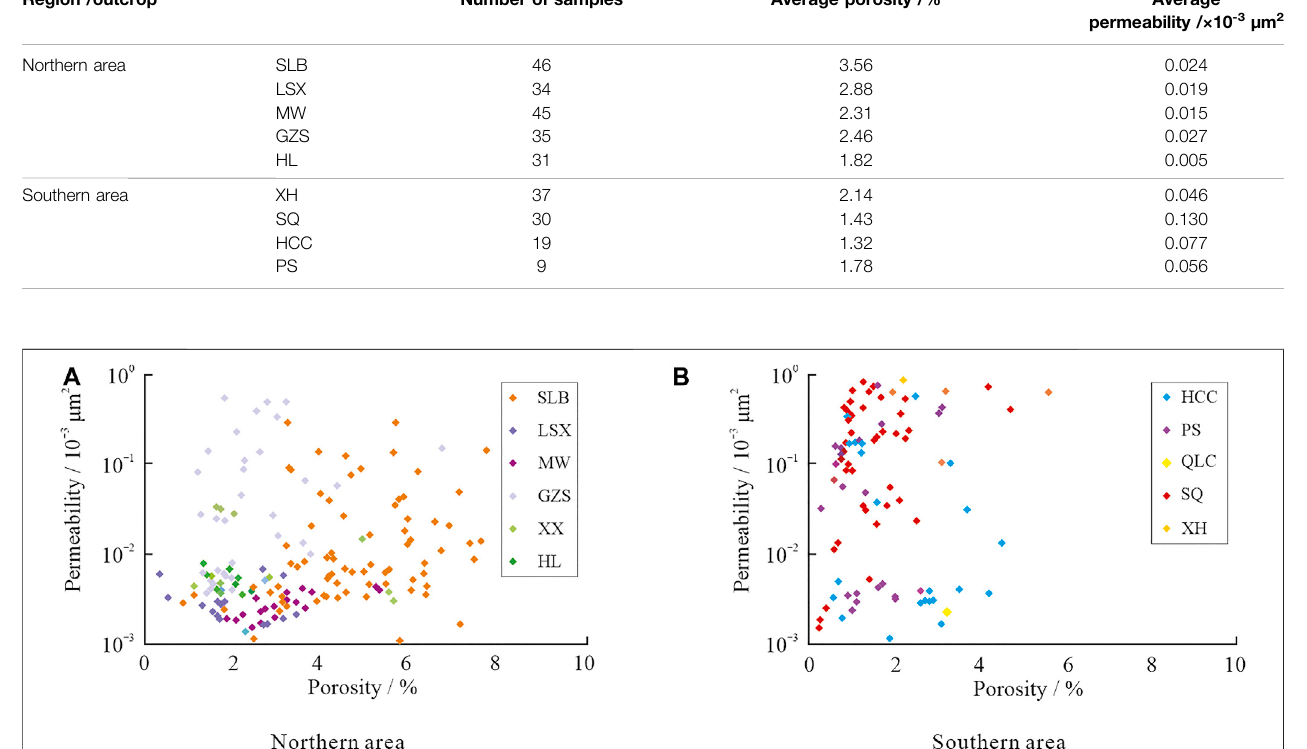
FIGURE 5 | Porosity-permeability intersection diagram of the Xiaoheba formation of different areas in Southeast Sichuan. (A) Northern, (B) Southern.